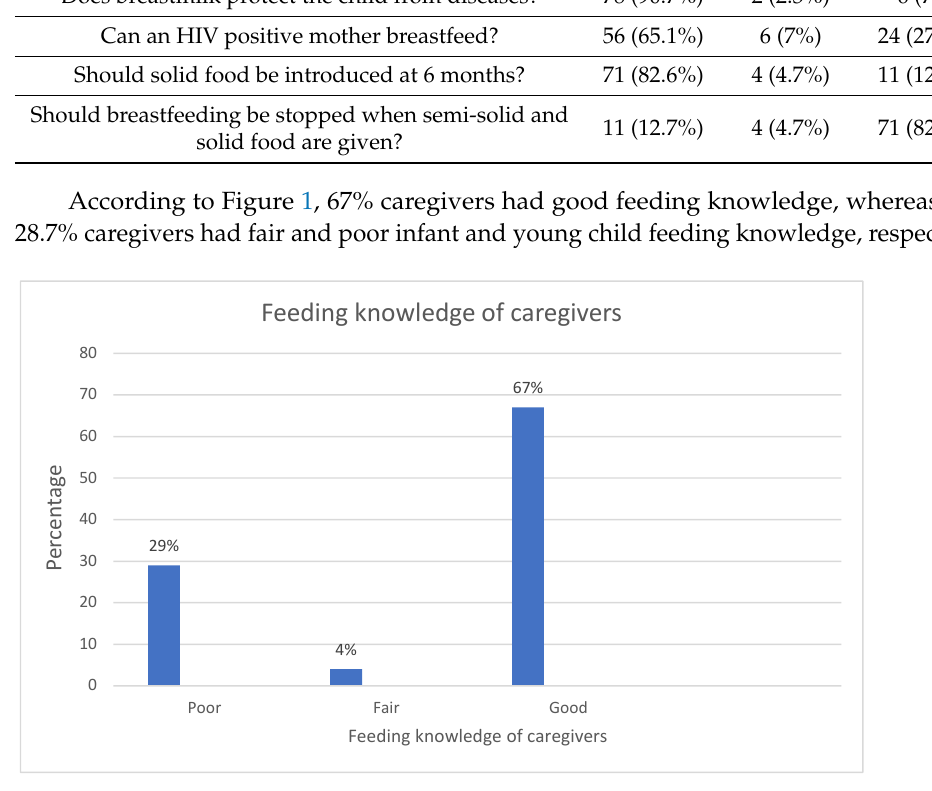
Table 2. Knowledge of participants regarding infant feeding, % in rows ( n = 86).